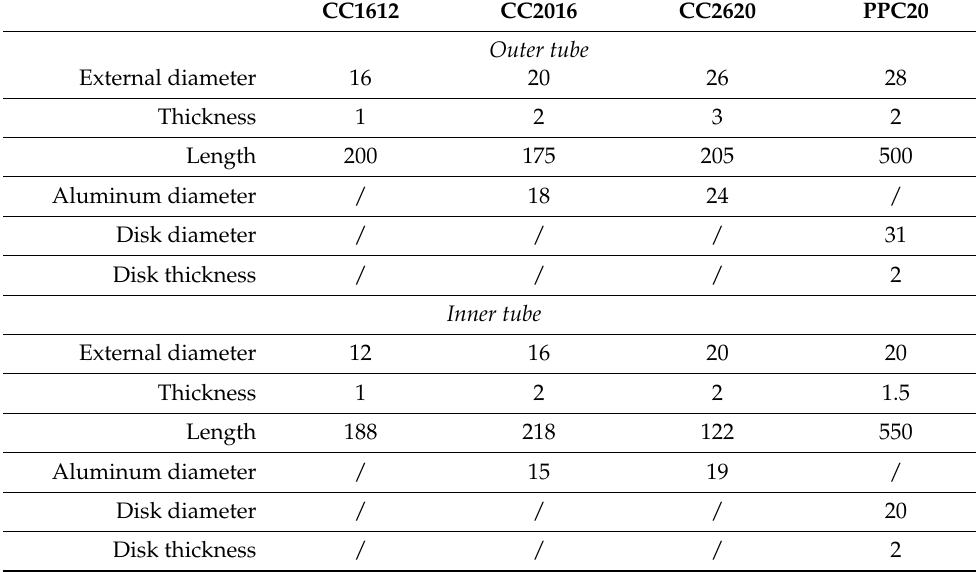
Table 1. Dimensions in [mm] of the proposed capacitance